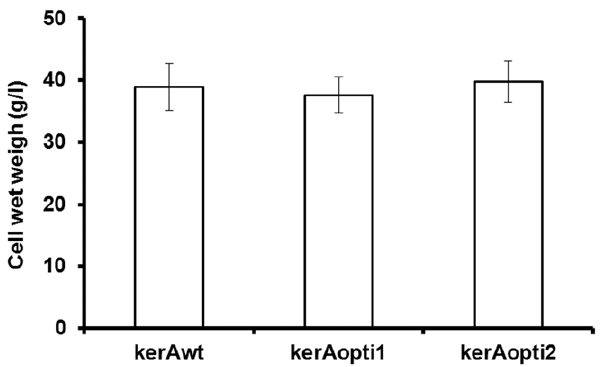
Figure 6. Comparative biomass concentration of P. pastori pPICZ a -kerAwt, pPICZ a -kerAopti1 and pPICZ a -kerAopti2 at 96 h. The values represent means 6 SD (n=3). Results showed there was no significant difference in biomass concentration of every positive transformant (P . 0.05).